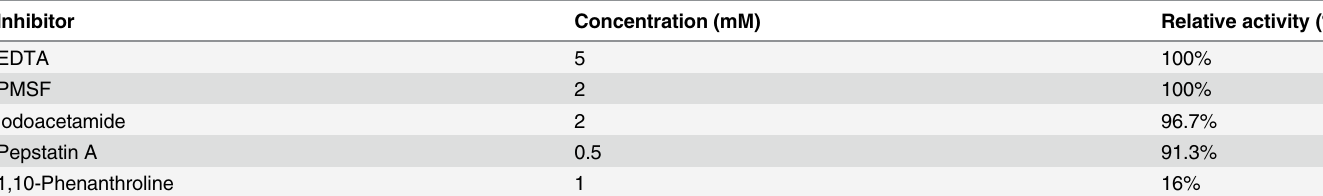
Table 2. Effect of inhibitors on the activity of cupincin.